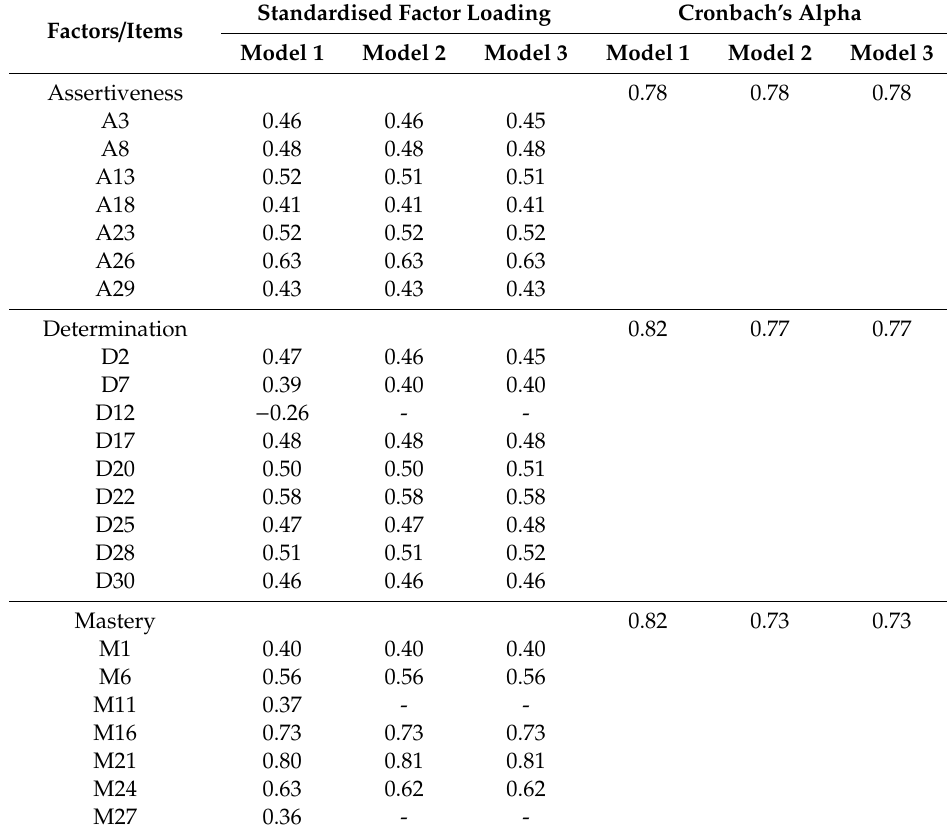
Table 3. Standardised factor loading, cronbach’s alpha of the final measurement model of SCS-AE, 31